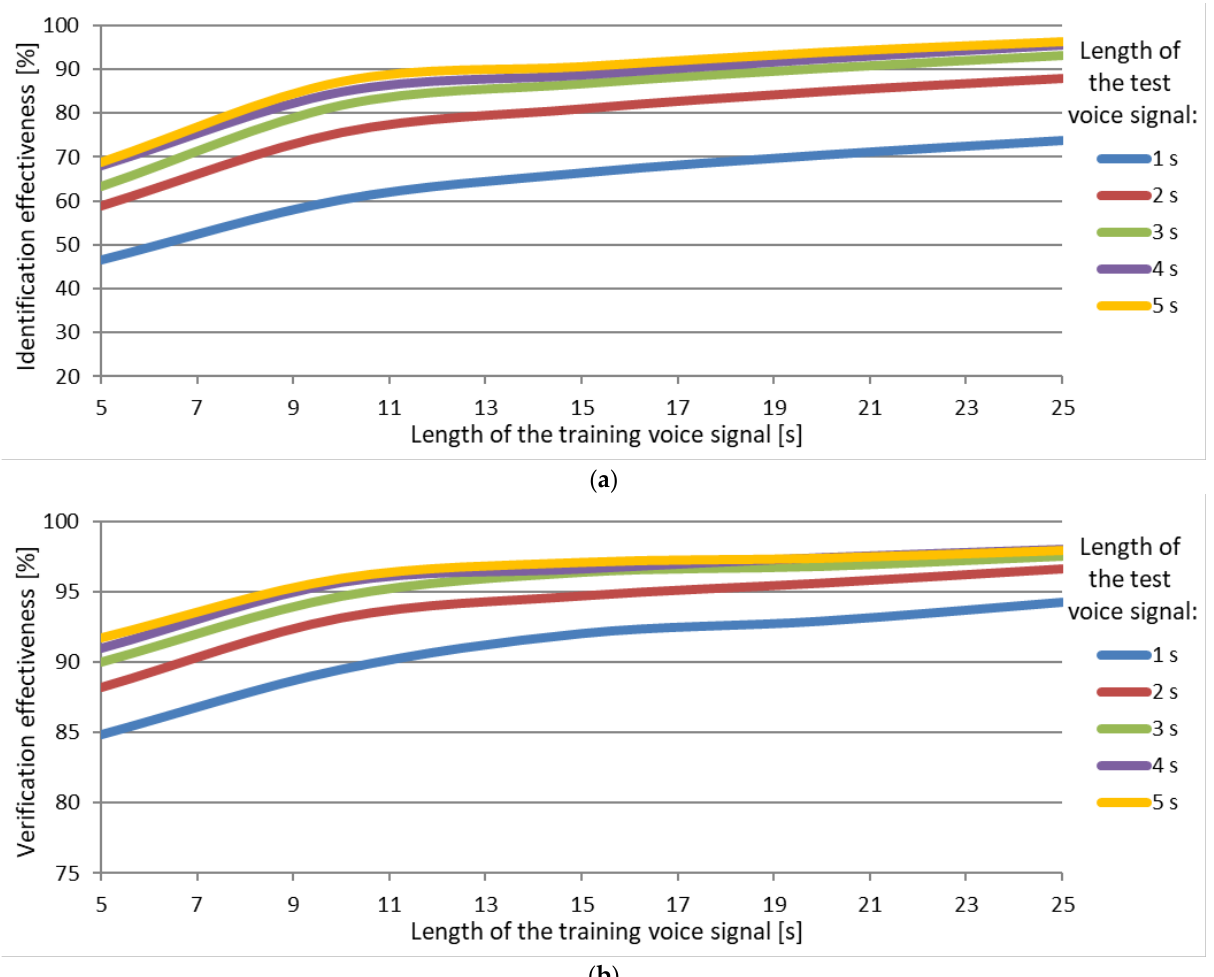
Figure 7. Speaker identification and verification effectiveness for variable lengths of speech signal, ( a ) Identification; ( b ) Verification. ( a ) Identification; ( b ) Verification.